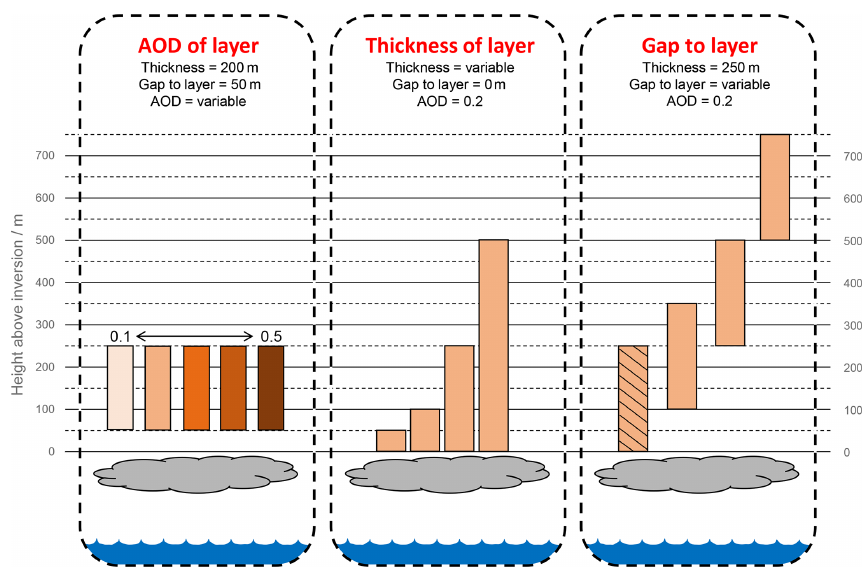
Figure 2. Schematic showing the experiments performed for the aerosol sensitivity simulations. The hatched experiment is named the base experiment and is used to provide an initial analysis of the semi-direct effect in Sect. 3.2. AOD stands for aerosol optical depth and is given at a mid-band wavelength of 505nm.